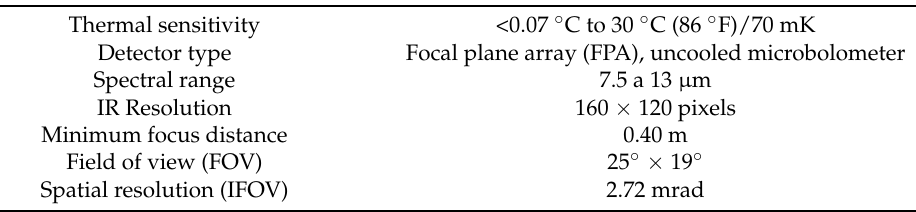
Table 3. Infrared camera specifications [41].